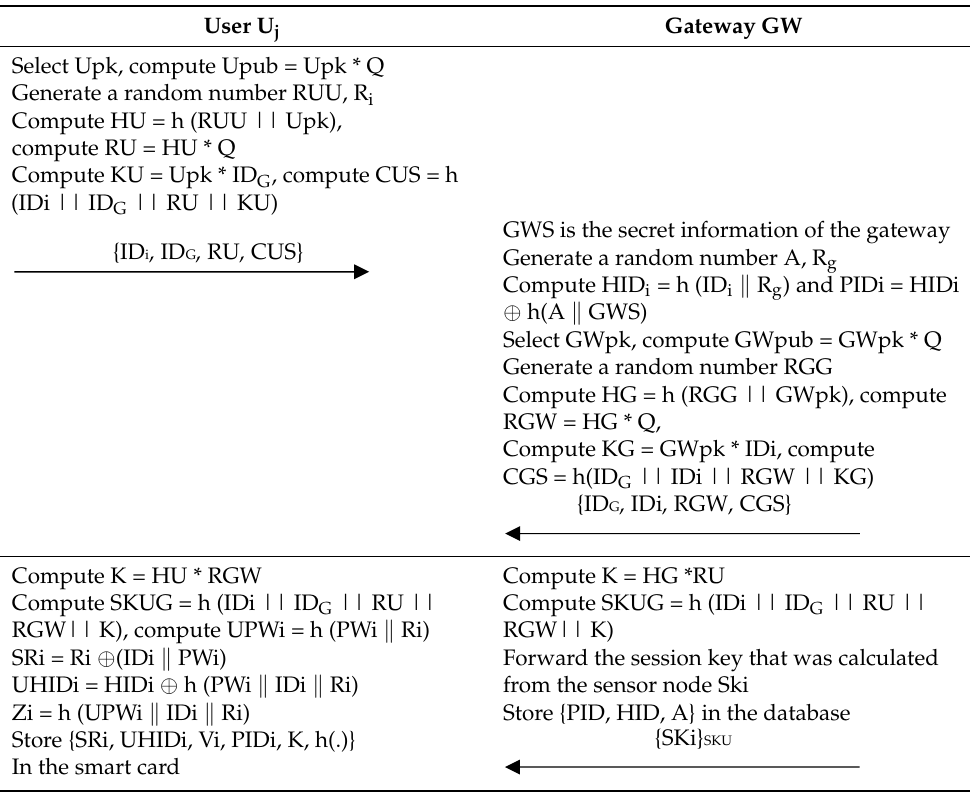
Figure 3. The flow diagram of the sensor registration phase. Table 4. User registration phase.